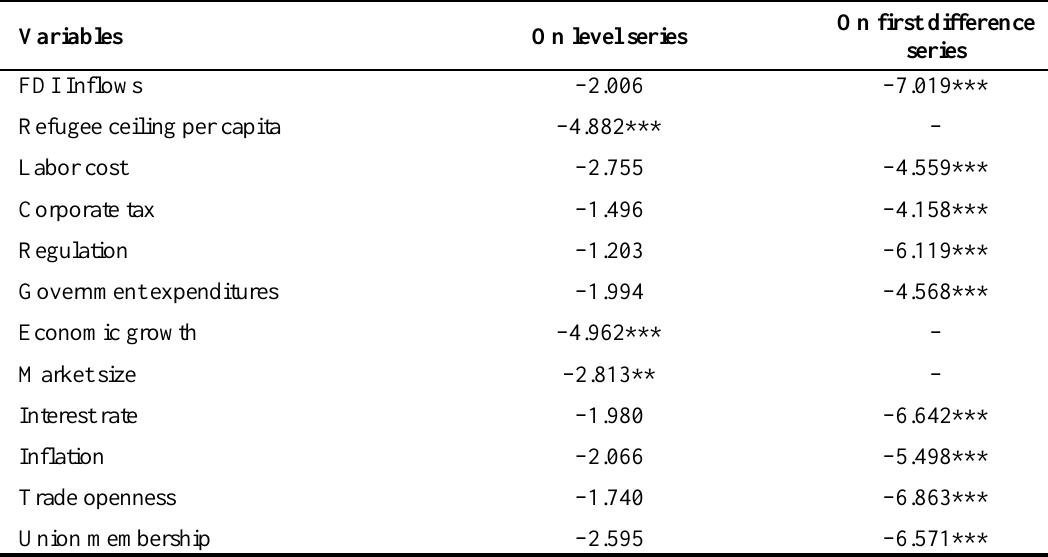
Table 2: The Results of Dickey–Fuller Unit Root Test